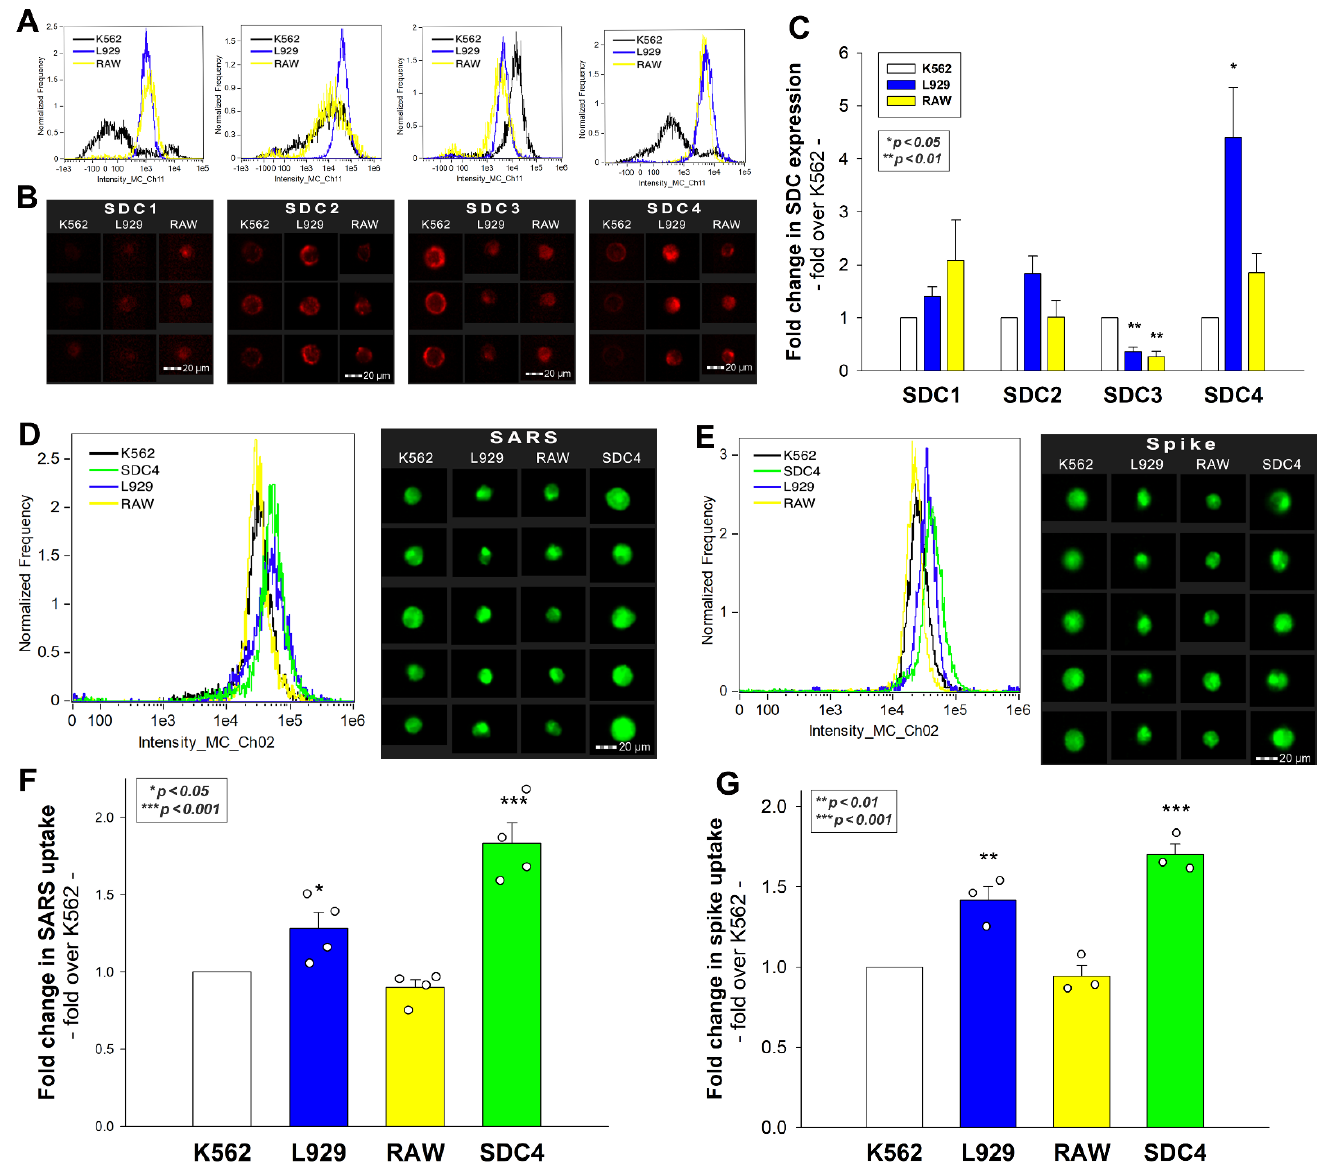
Figure 4. Flow cytometric assessment of SDC expression and SARS-CoV-2’s and its spike protein’s uptake in human and murine cell lines. SDC expression of L929, RAW, and K562 cells was analyzed with imaging flow cytometry using fluorescently labeled SDC antibodies. ( A , B ) Representative flow cytometry histograms and fluorescent images showing SDC expression levels in L929, RAW, and K562 cells. Scale bar = 20 μm . ( C ) Detected SDC expression level cells were normalized to K562s. The bars represent the mean + SEM of three independent experiments. Statistical significance was assessed with analysis of variance (ANOVA). * p < 0.01; ** p < 0.001. ( D – G ) L929, RAW, and K562 cells and SDC4 transfectants (created in K562 cells) were incubated with either inactivated SARS- CoV-2 (at 1 MOI) or spike protein (50 nM) for 3 h at 37 °C. After incubation, the cells were washed, trypsinized, fixed, permeabilized, and treated with antibodies specific for the spike glycoprotein (and AF 488-labeled secondary antibodies). Cellular uptake of SARS-CoV-2 and spike was then an- alyzed with imaging flow cytometry. ( D , E ) Representative flow cytometry histograms and fluores- cent images showing the intracellular fluorescence of SARS-CoV-2- and spike-treated cells. Scale bar = 20 μm . ( F , G ) Detected fluorescence intensities were normalized to SARS-CoV-2- or spike- treated K562 cells as standards. The bars represent the mean + SEM of four ( F ) and three ( G ) inde- pendent experiments. Statistical significance vs. standards was assessed with ANOVA. * p < 0.05; ** p < 0.01; *** p < 0.001.